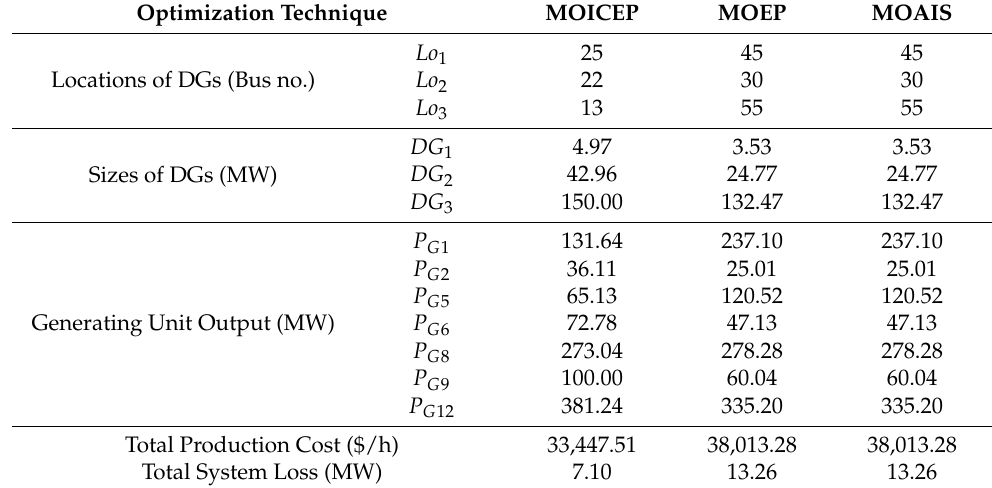
Table 19. Results of the integrated ED problem with a valve-point loading effect and DG installation of the IEEE 57-Bus RTS ( w 1 = 0.5 and w 2 = 0.5). Optimization Technique MOICEP MOEP MOAIS Lo 1 Locations of DGs (Bus no.)